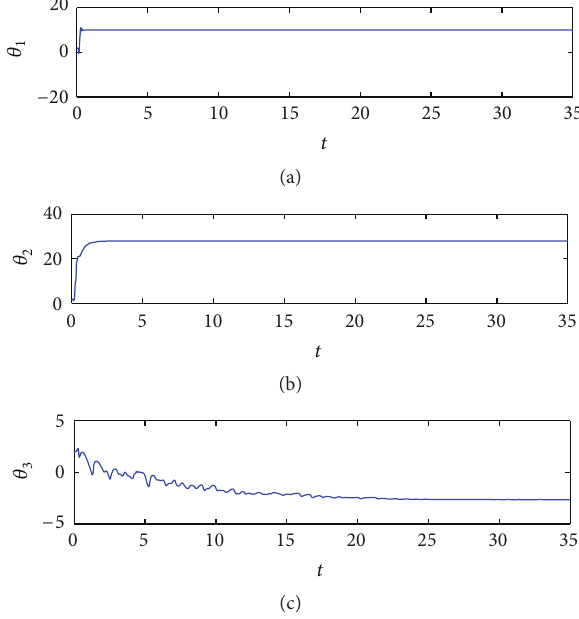
Figure 3: Time response of the control input in Example 1.